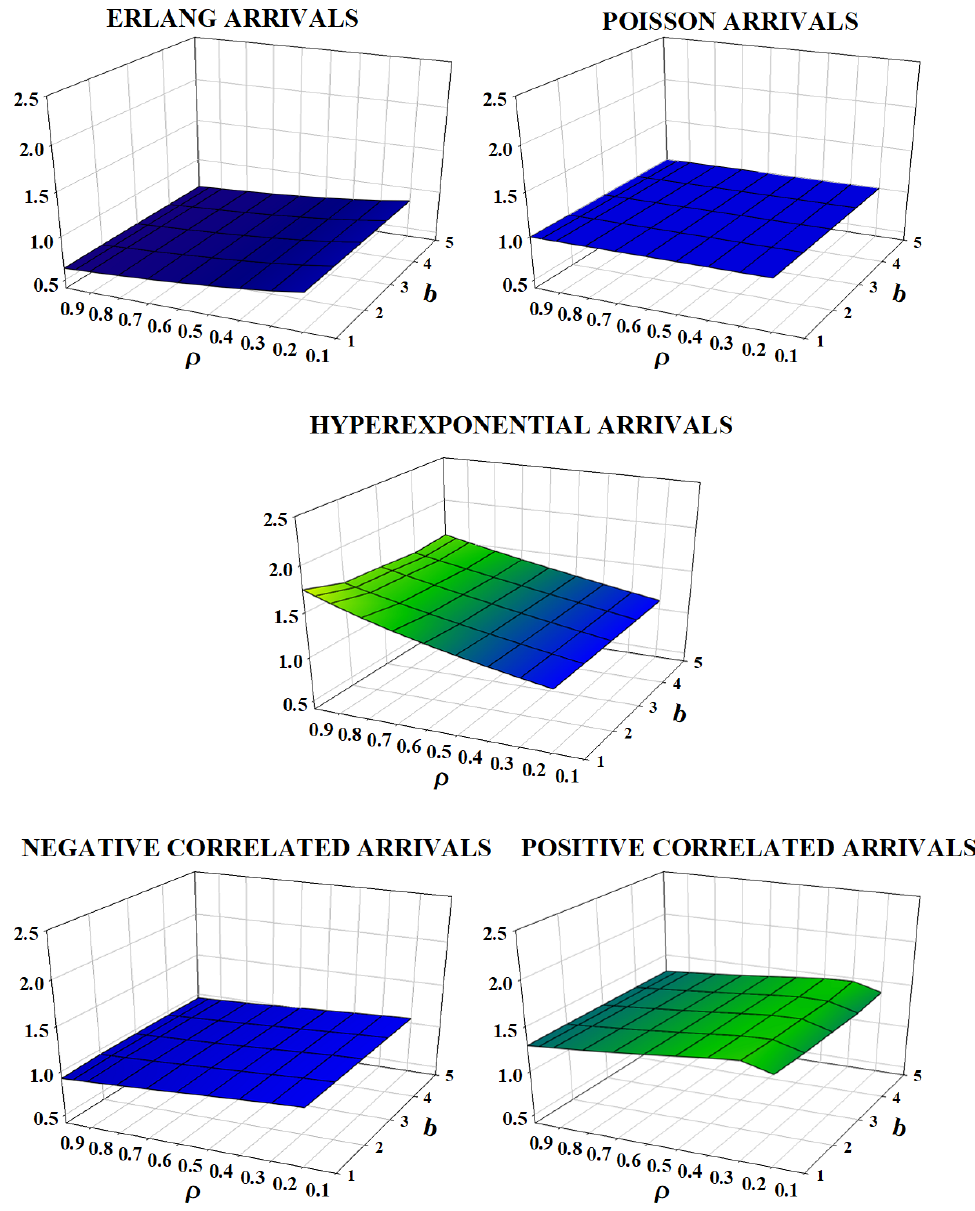
Figure 9. Mean idle time ( µ (cid:48)